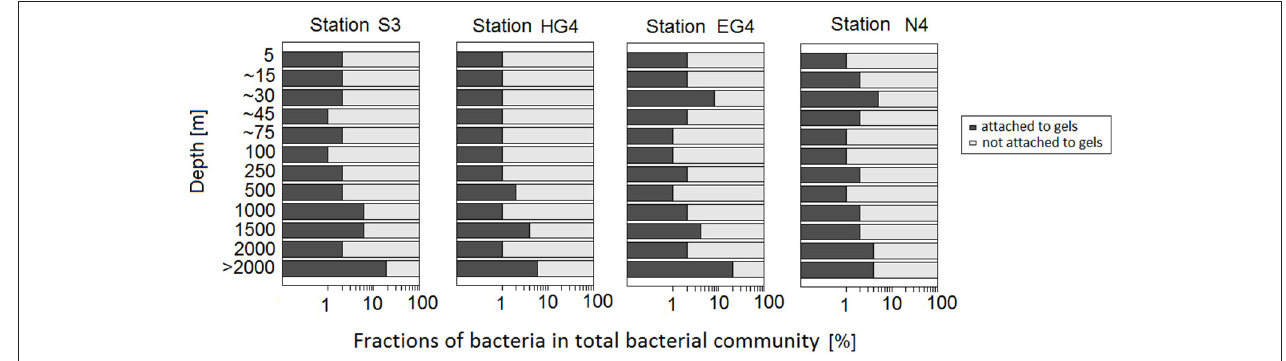
FIGURE 9 | Fractions of bacteria in the total bacterial community (%) over depth at the four sampling stations. Dark gray bars represent data for bacteria attached to gel particles. Light gray bars represent bacterioplankton fractions. Depths indicated with “ ∼ ” represent medians of the four stations (as sampling depths in the euphotic zone were slightly adjusted at each station to sample the chlorophyll maximum and its gradient). “ > 2,000m” refers to depths below 2,000m. X-axis has logarithmic